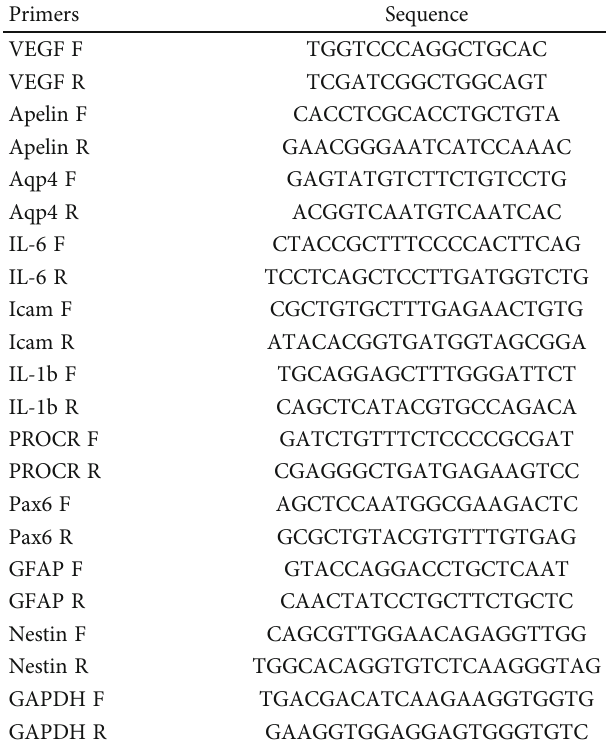
Table 1: Primers used in